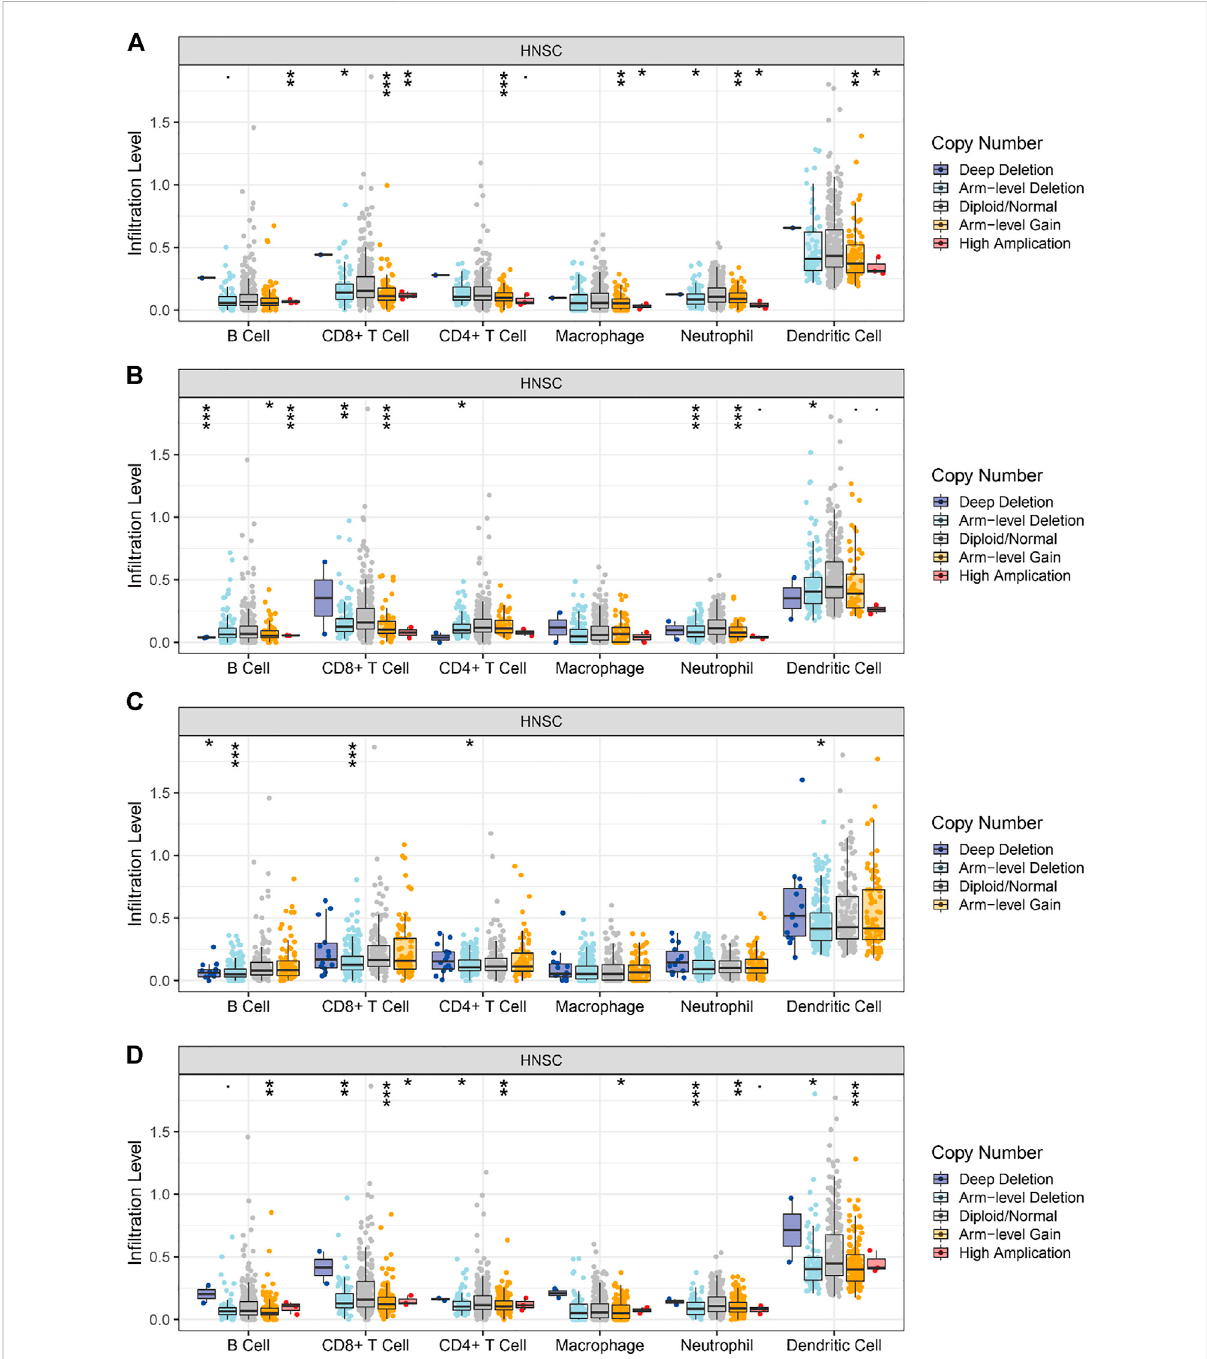
FIGURE 12 Correlation of BAK1 , NLRP1 , CHMP7 , and RIPK1 gene copy number variation and immune in fi ltration. (A) Correlation between BAK1 gene copy number variation and B cell, CD8 + T cell, CD4 + T cell, macrophage, neutrophil, dendritic cell (DC) in fi ltration; (B) Correlation between NLRP1 gene copy number variation and B cell, CD8 + T cell, CD4 + T cell, macrophage, neutrophil, DC in fi ltration; (C) Correlation between CHMP7 gene copy numbervariationandBcell,CD8 + Tcell,CD4 + Tcell,macrophage,neutrophil,andDCin fi ltration;and (D) Correlationbetween RIPK1 genecopy number variation and B cell, CD8 + T cell, CD4 + T cell, macrophage, neutrophil, and DC in fi ltration. * p < 0.05, ** p < 0.01, *** p <